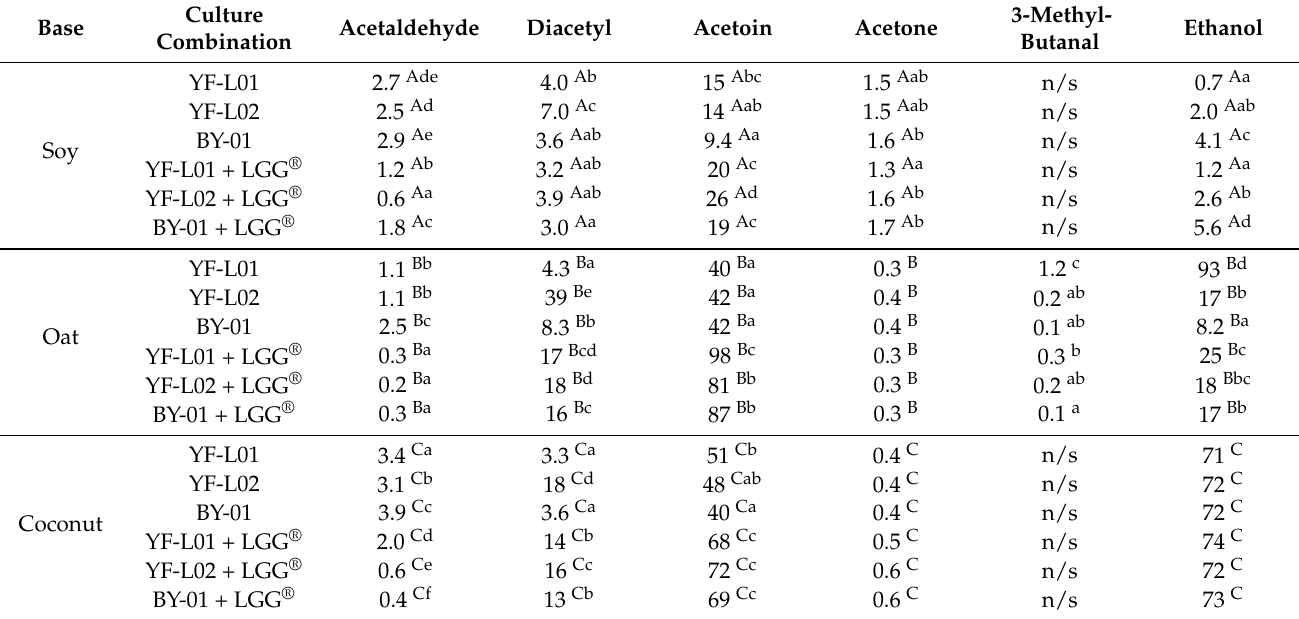
Means in the same column inside each base with different lowercase superscripts indicate significant differences between different culture combinations ( p < 0.05). “n/s” stands for “no signal”. Contents are measured in parts per